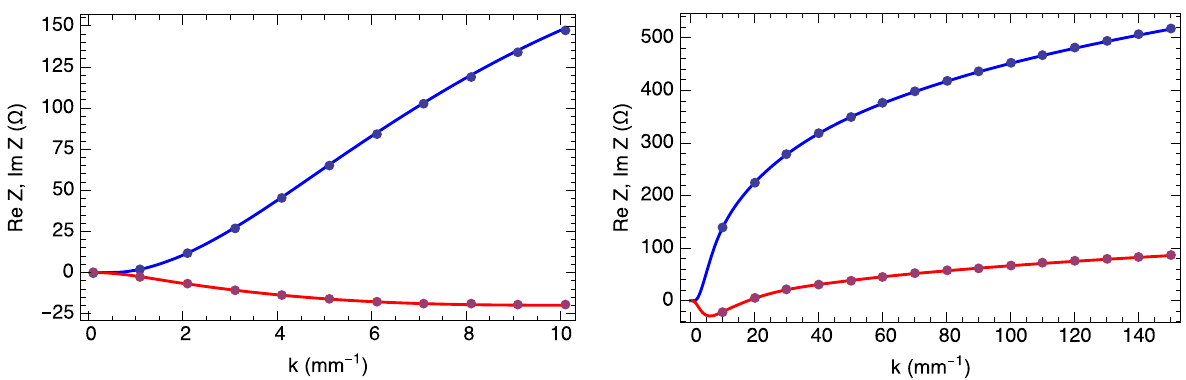
FIG. 7. Comparison of analytical calculations (shown by dots) with computer simulations (shown by solid lines): Re Z (blue) and Im Z